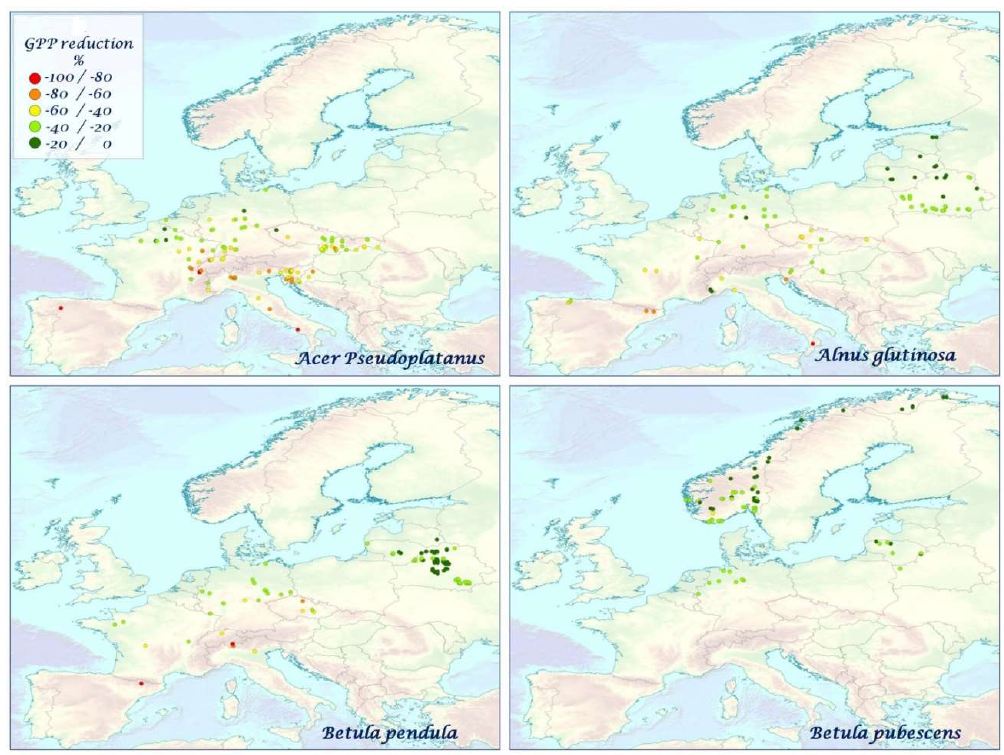
Figure 5. The mean species–specific GPP reduction (%) for A. pseudoplatanus, A. glutinosa, B. pendula, B. pubescens over the time period 2000–2010.